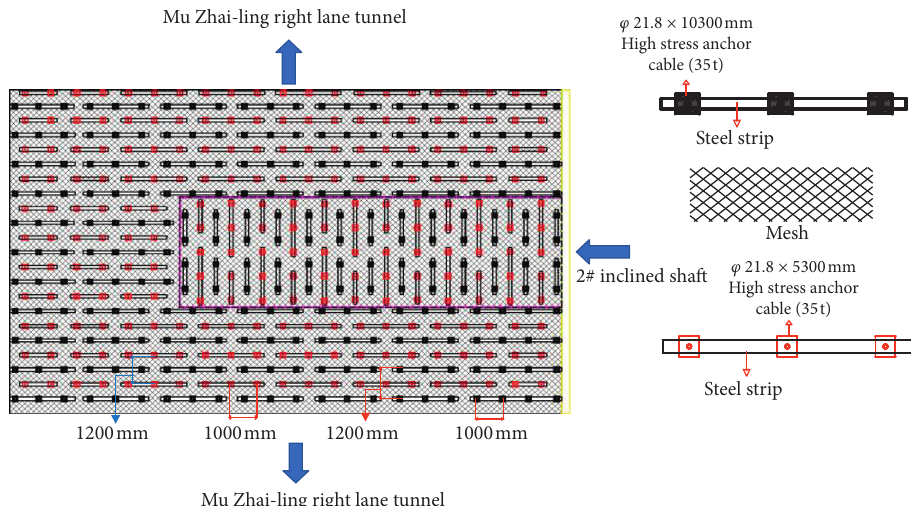
Figure 14: Plane expansion diagram of the tunnel